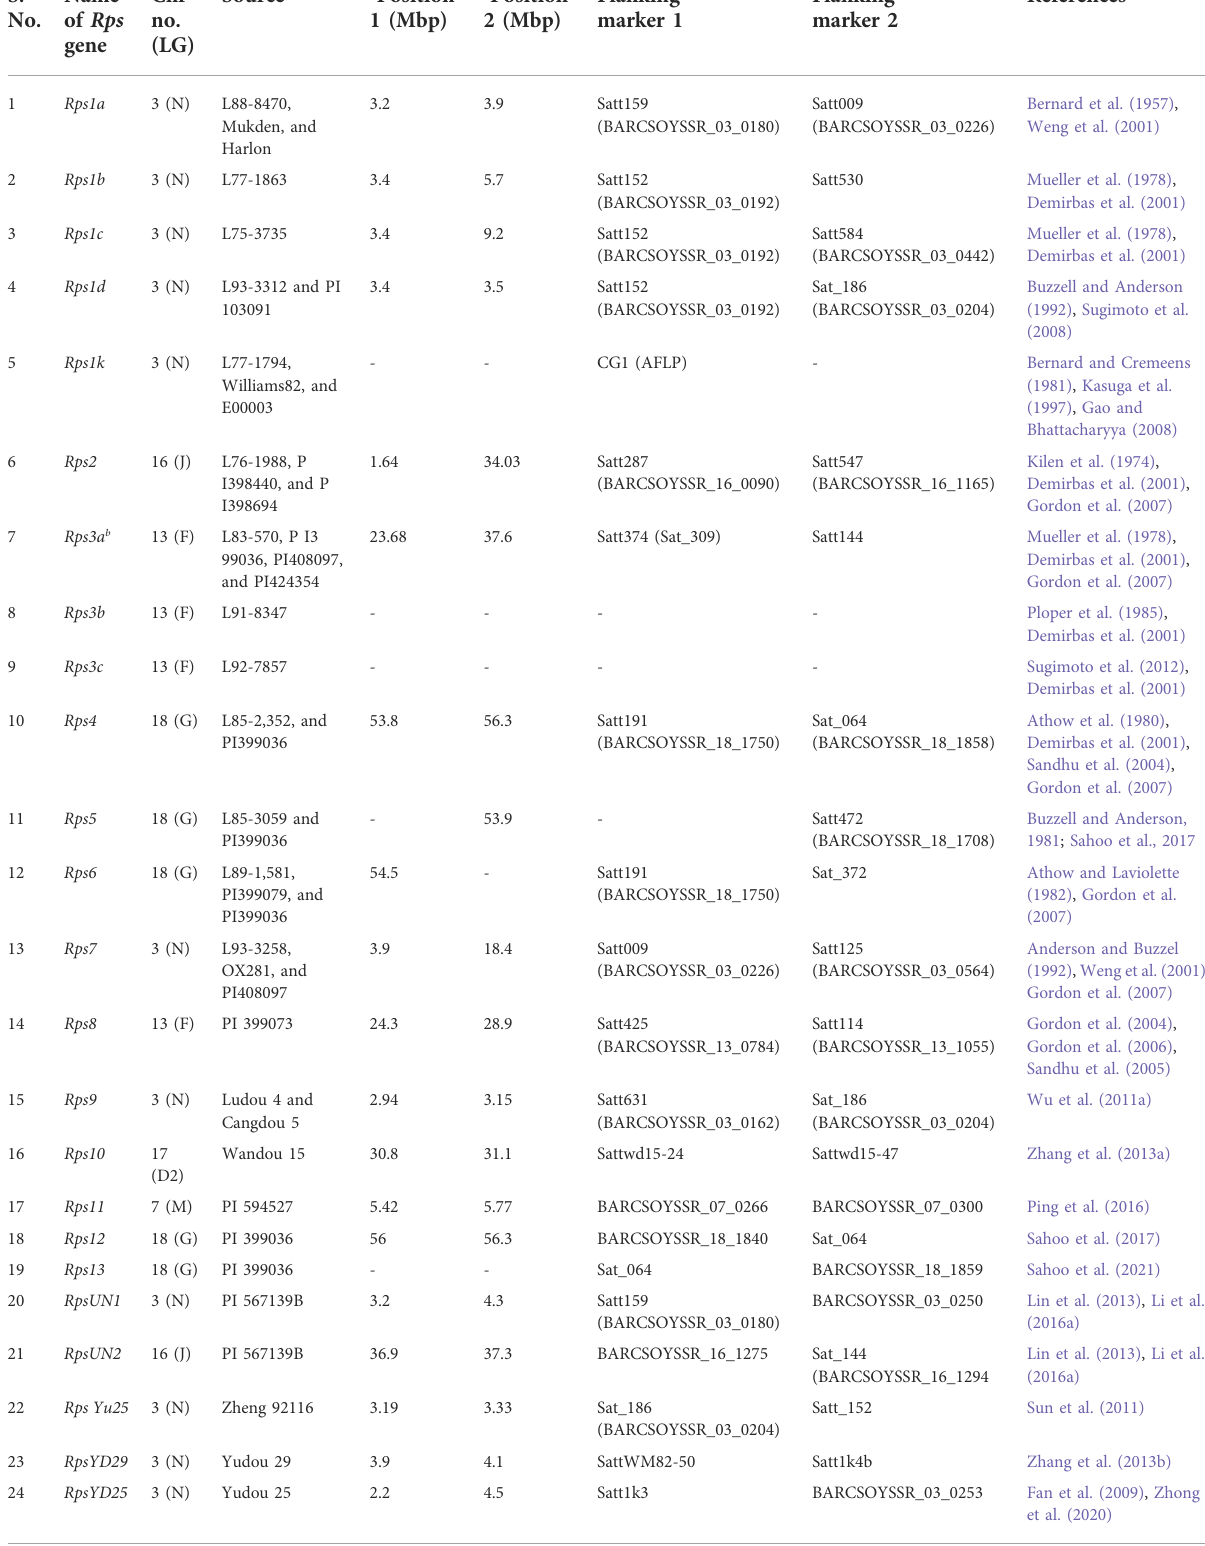
TABLE 1 Details of P. sojae- resistant genes ( Rps ), their source, chromosomal positions, and associated markers. S. Name No. of